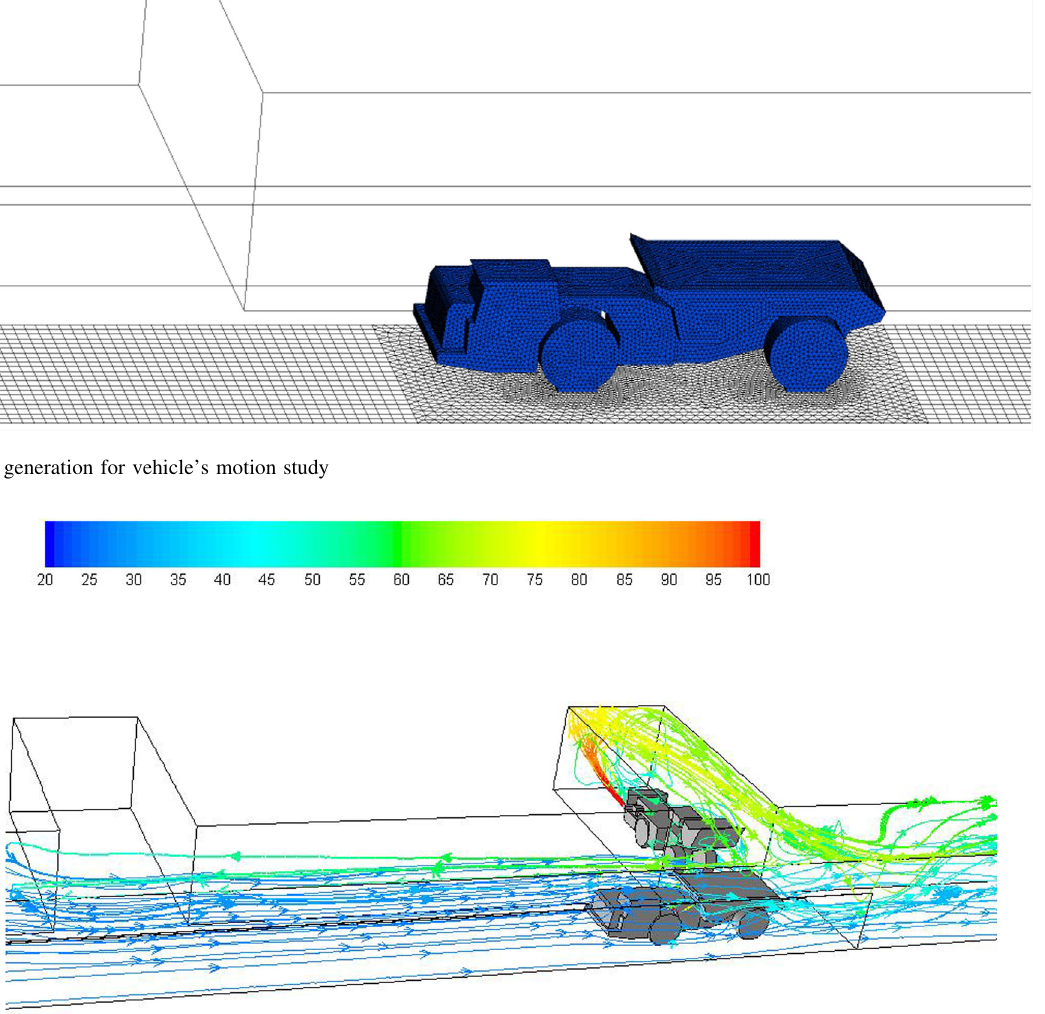
Fig. 6 Pathlines colored by temperature ( (cid:3) C) showing general flow features during the loading operation (legend 20–100 (cid:3) C)